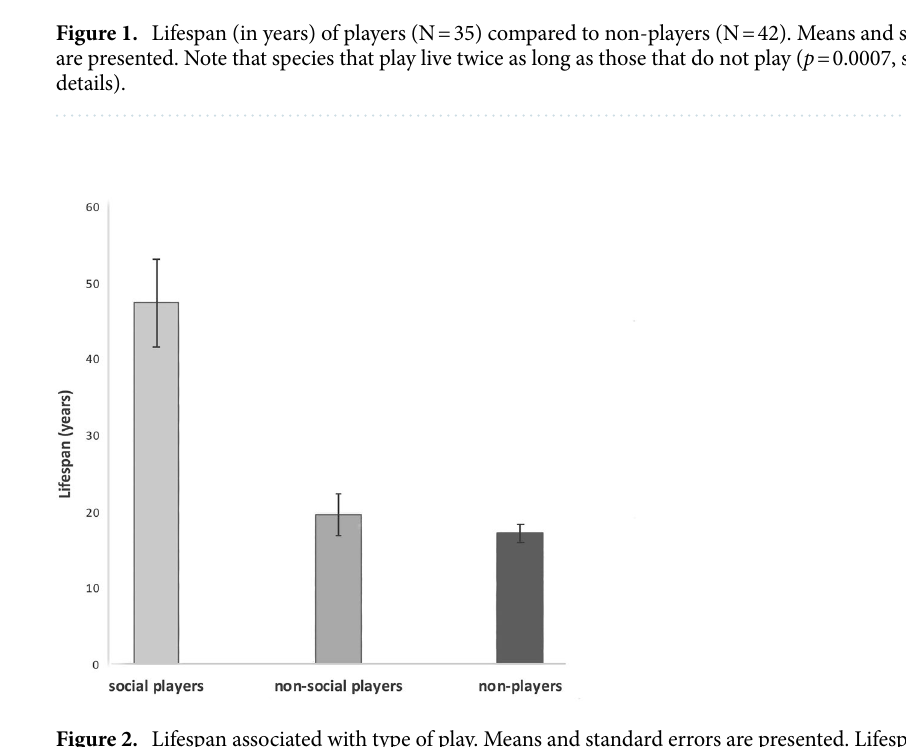
Figure 2. Lifespan associated with type of play. Means and standard errors are presented. Lifespan is substantially and significantly longer only in those species that perform social play. The lifespans of species that perform non-social play do not differ from those of the species that do not